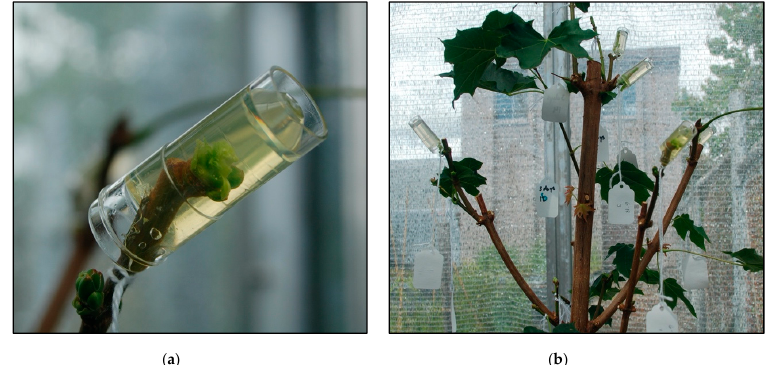
Figure 2. The 2011 application of 100 µ M oryzalin to meristems of Acer platanoides ‘Emerald Queen’. ( a ) a representative tree that was cut back and treated as meristems emerged from dormancy and ( b ) closeup of meristem exposed by removing bud scales as emerged after dormancy.